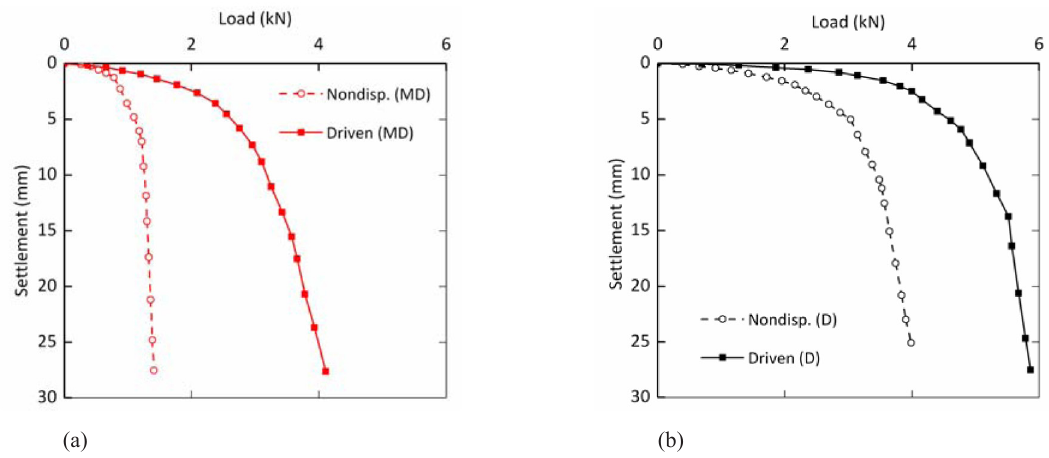
sand(a) Fig. 4. Comparison of non-displacement vs. driven pile tests: (a) Medium dense sand; (b) dense